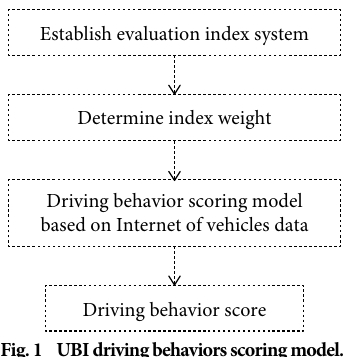
Fig. 1 UBI driving behaviors scoring